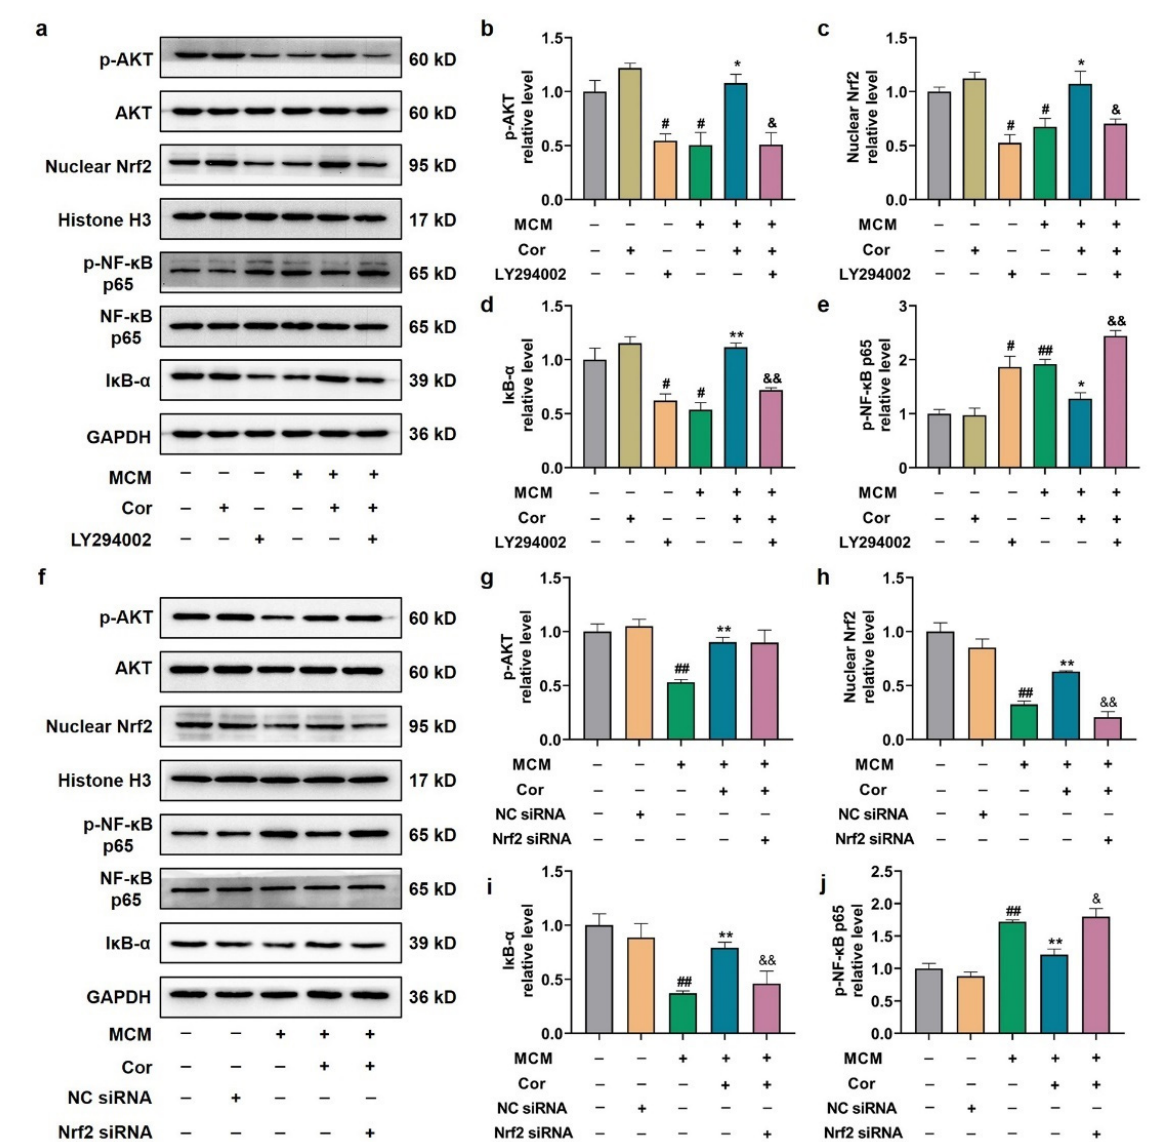
Figure 9. Cornuside protected C6 cells induced by MCM via AKT/Nrf2/NF- κ B . ( a ) C6 cells were